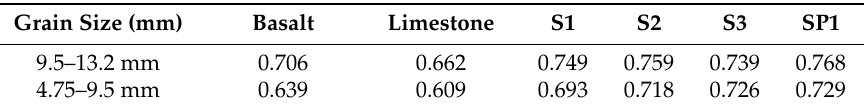
Table 10. Sphericity of investigated coarse aggregate.